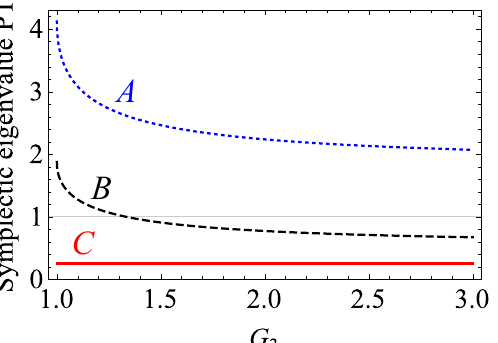
Figure 6. The dependence of smallest symplectic eigenvalues E ˆ on power gain G 3 under the condition of G 1 = G 2 = 2 and η = β = 1.